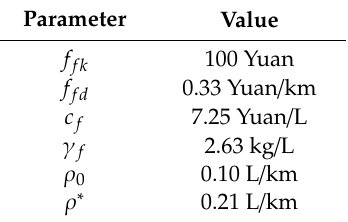
Table 6. Relevant parameters of Capacitated Fuel Vehicle Routing Problem with Time Windows (CVRPTW)